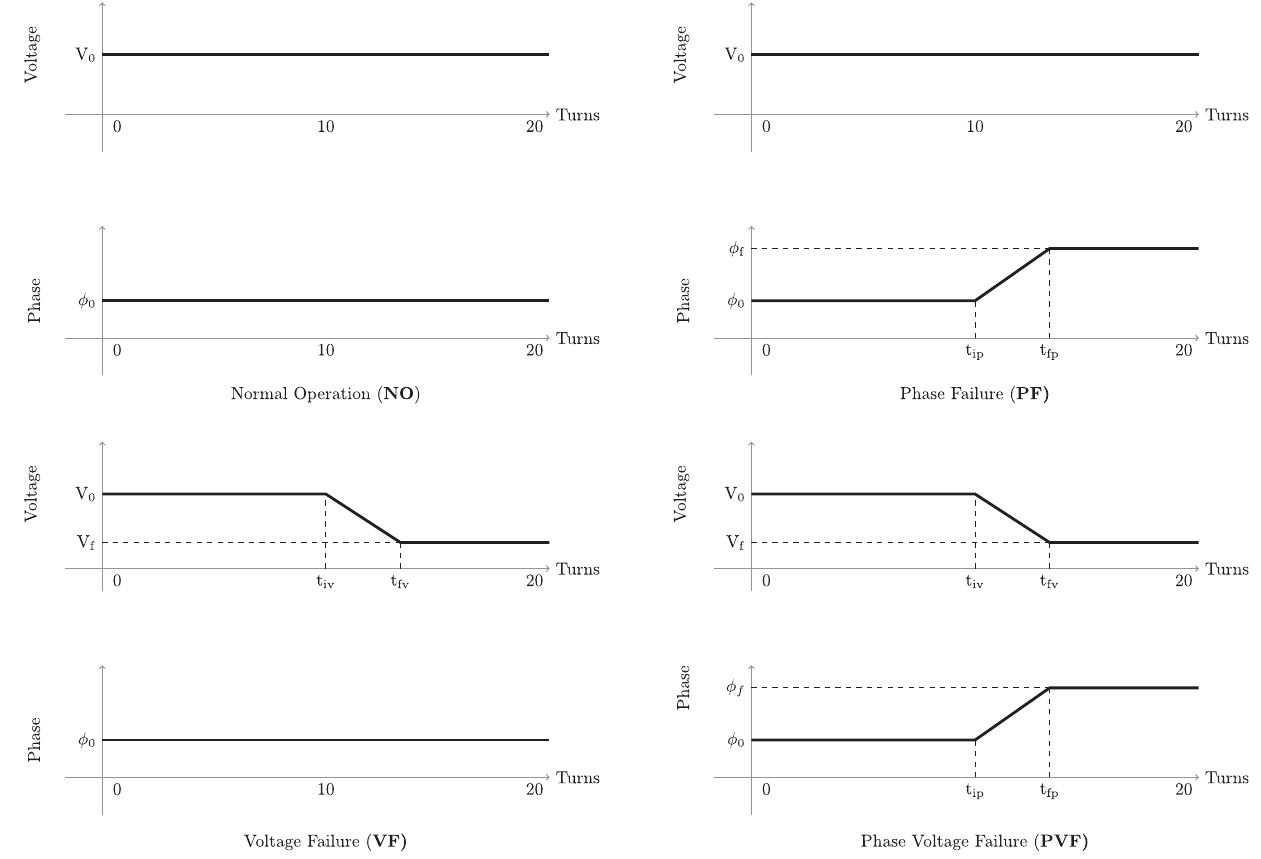
FIG. 6. Schematic ways of changing the voltage and phase through the numbers of turns during the tracking once the QSS is reached. The normal operation (NO) case (top left), the phase failure (PF) case (top right), the voltage failure (VF) case (bottom left), the phase voltage failure (PVF) case (bottom right). For the PVF cases the changes start at different turns (t